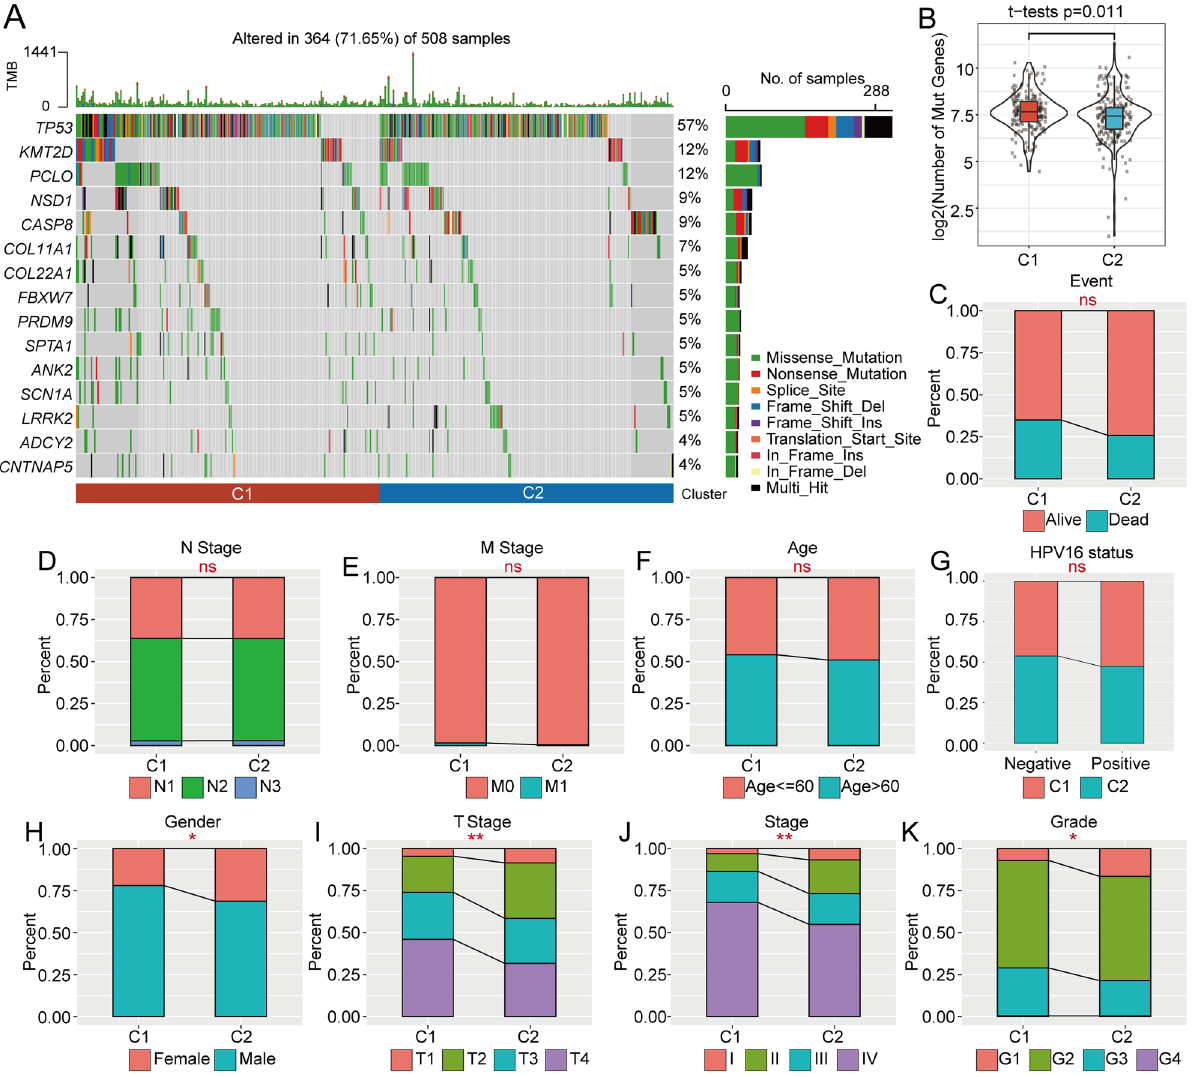
Figure 3. m6A modification subtypes show a close relationship with common genomic mutations. ( A ) Significantly altered genes and signatures in the C1 and C2 subgroups. ( B ) The TMB differed between the C1 and C2 subgroups. ( C ) Number of mutated genes between the C1 and C2 subgroups. ( D – K ) The m6A- associated subgroups C1 and C2 presented significantly different clinical feature